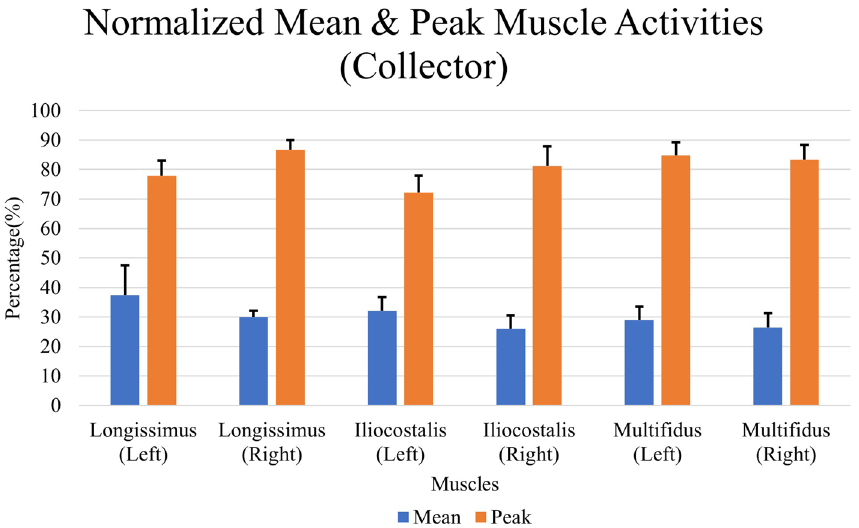
Figure 6. The average mean and peak EMG activities during LF